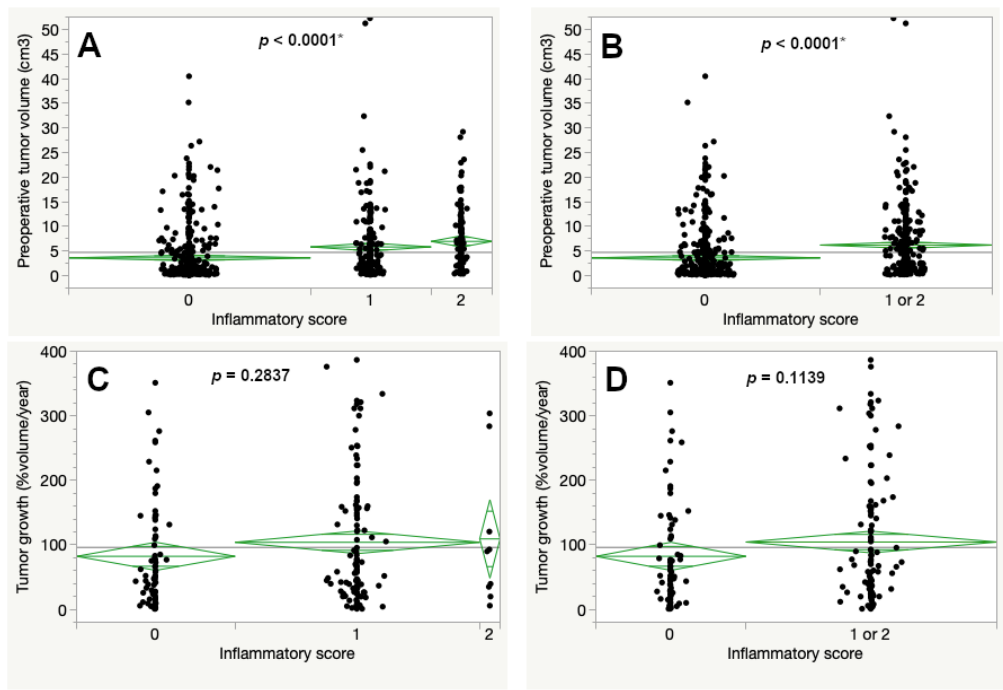
Figure 5. Preoperative tumor volume ( A , B ) and percentual volumetric tumor growth ( C , D ) according to the inflammatory score (ANOVA; an asterisk (*) marks statistically significant results).